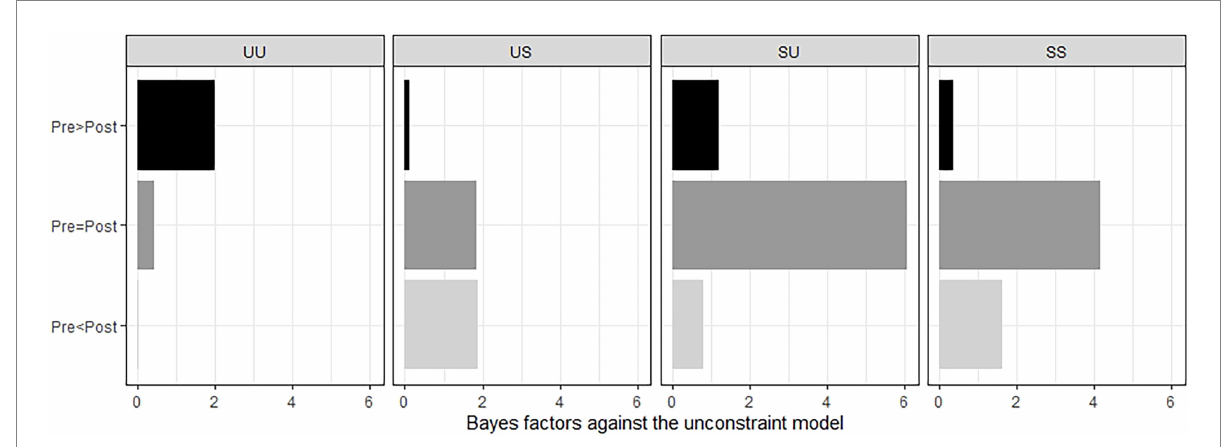
FIGURE 2 Bayes factors for different hypotheses compared to unconstraint model depending on vignette